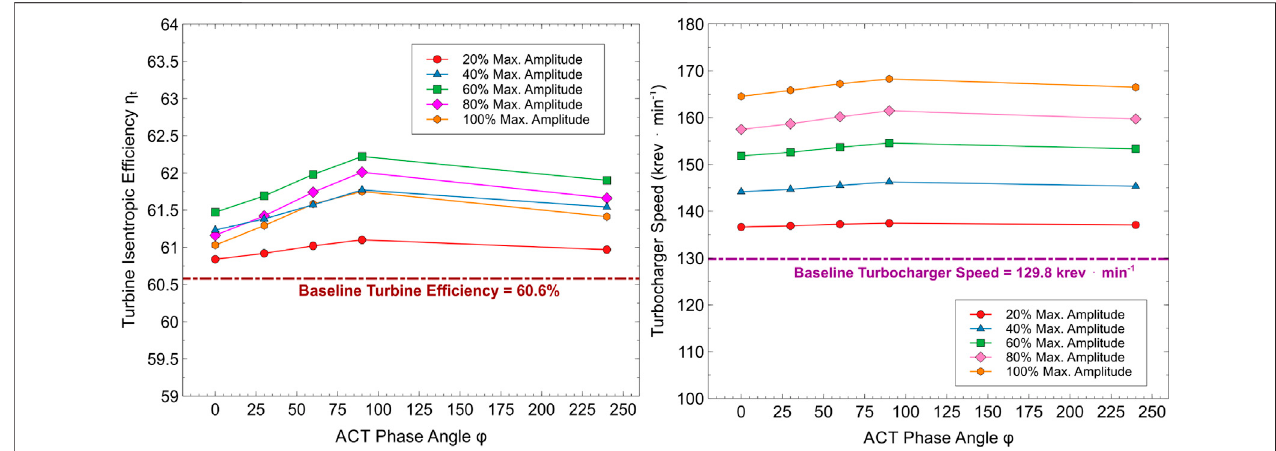
FIGURE 10 | Impact of amplitude ratio and phase angle on (left) : turbine isentropic ef fi ciency η t and (right) : turbocharger shaft speed.